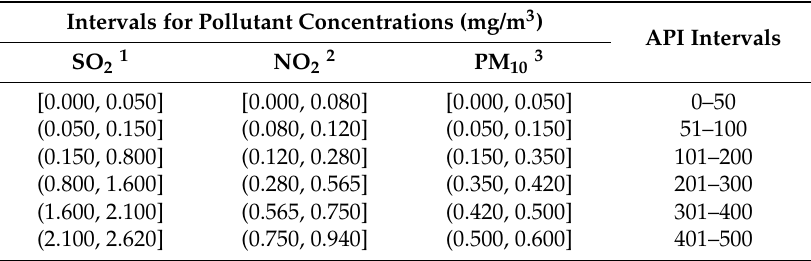
Table 2. Intervals for pollutant concentrations and corresponding